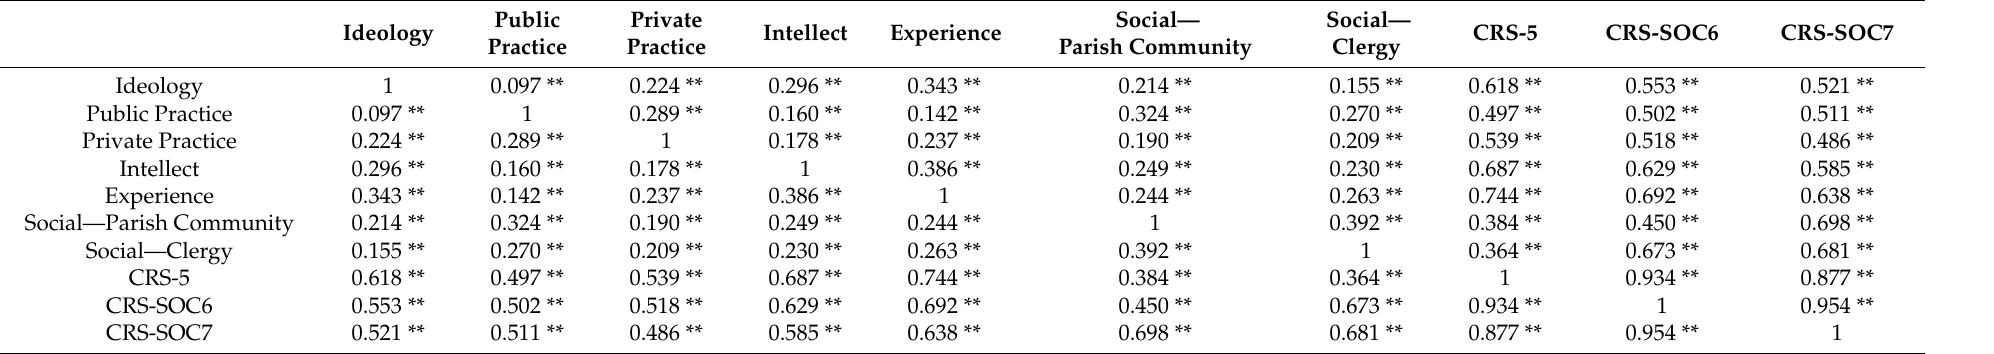
Social— Parish Community